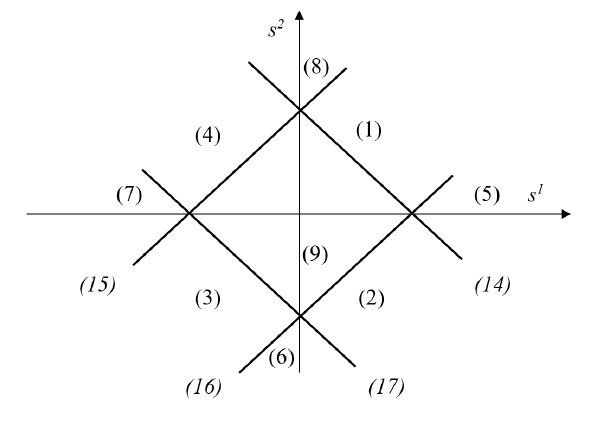
Figure 4: The classification of vectors, which correspond to weight coeflcients of Hopfield neural network, by construction in dual